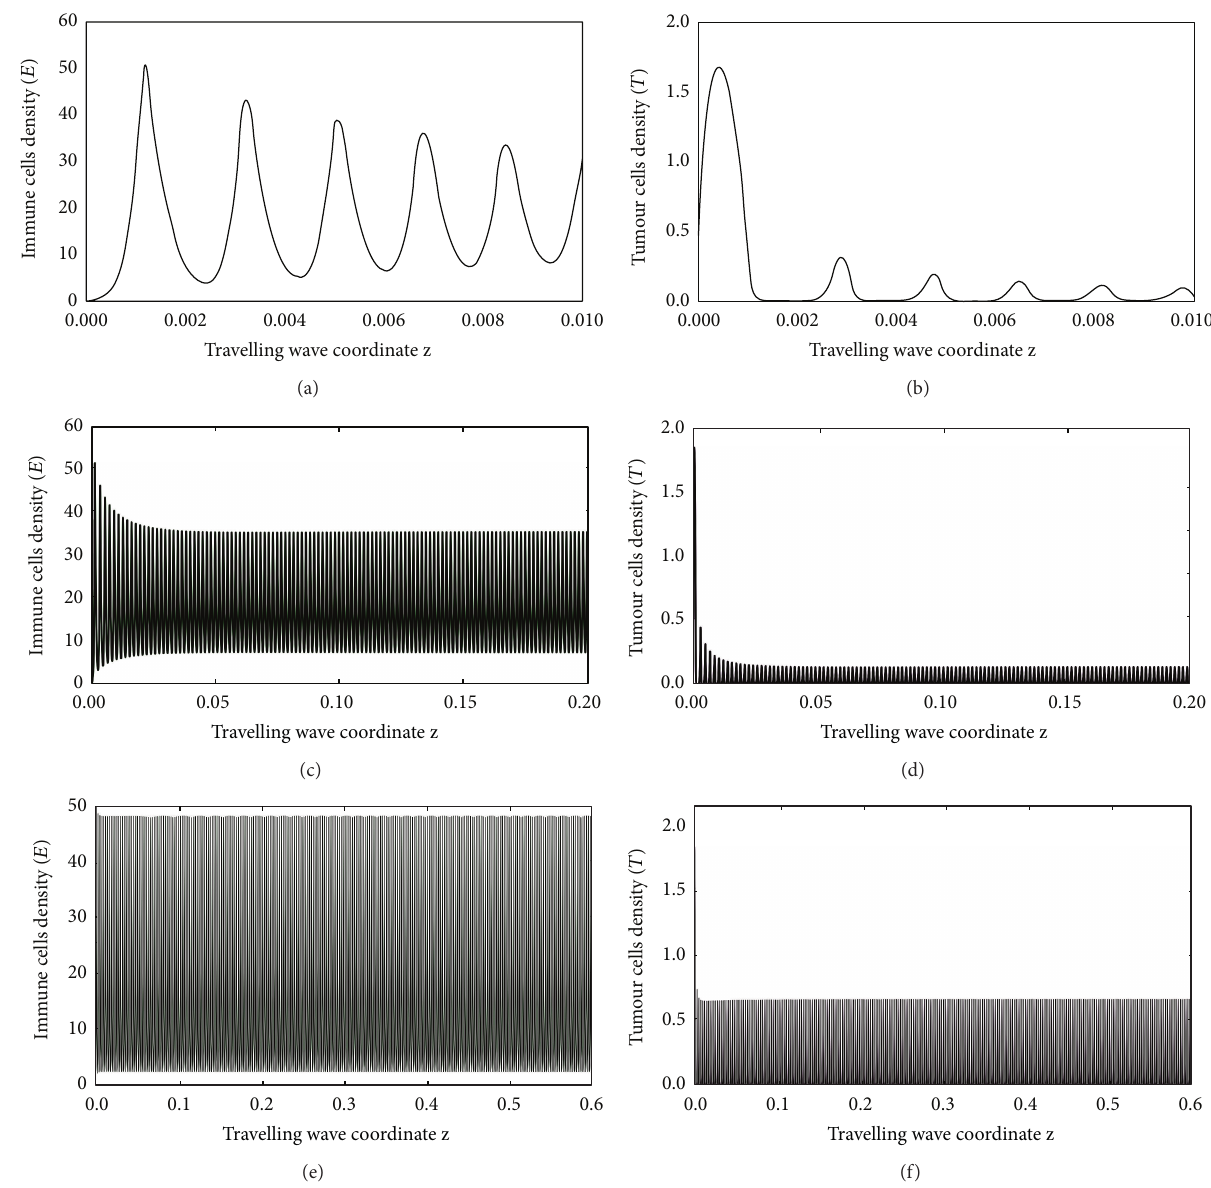
Figure 2: Travelling wave solutions of the system (3) for different travelling wave coordinates without treatment.